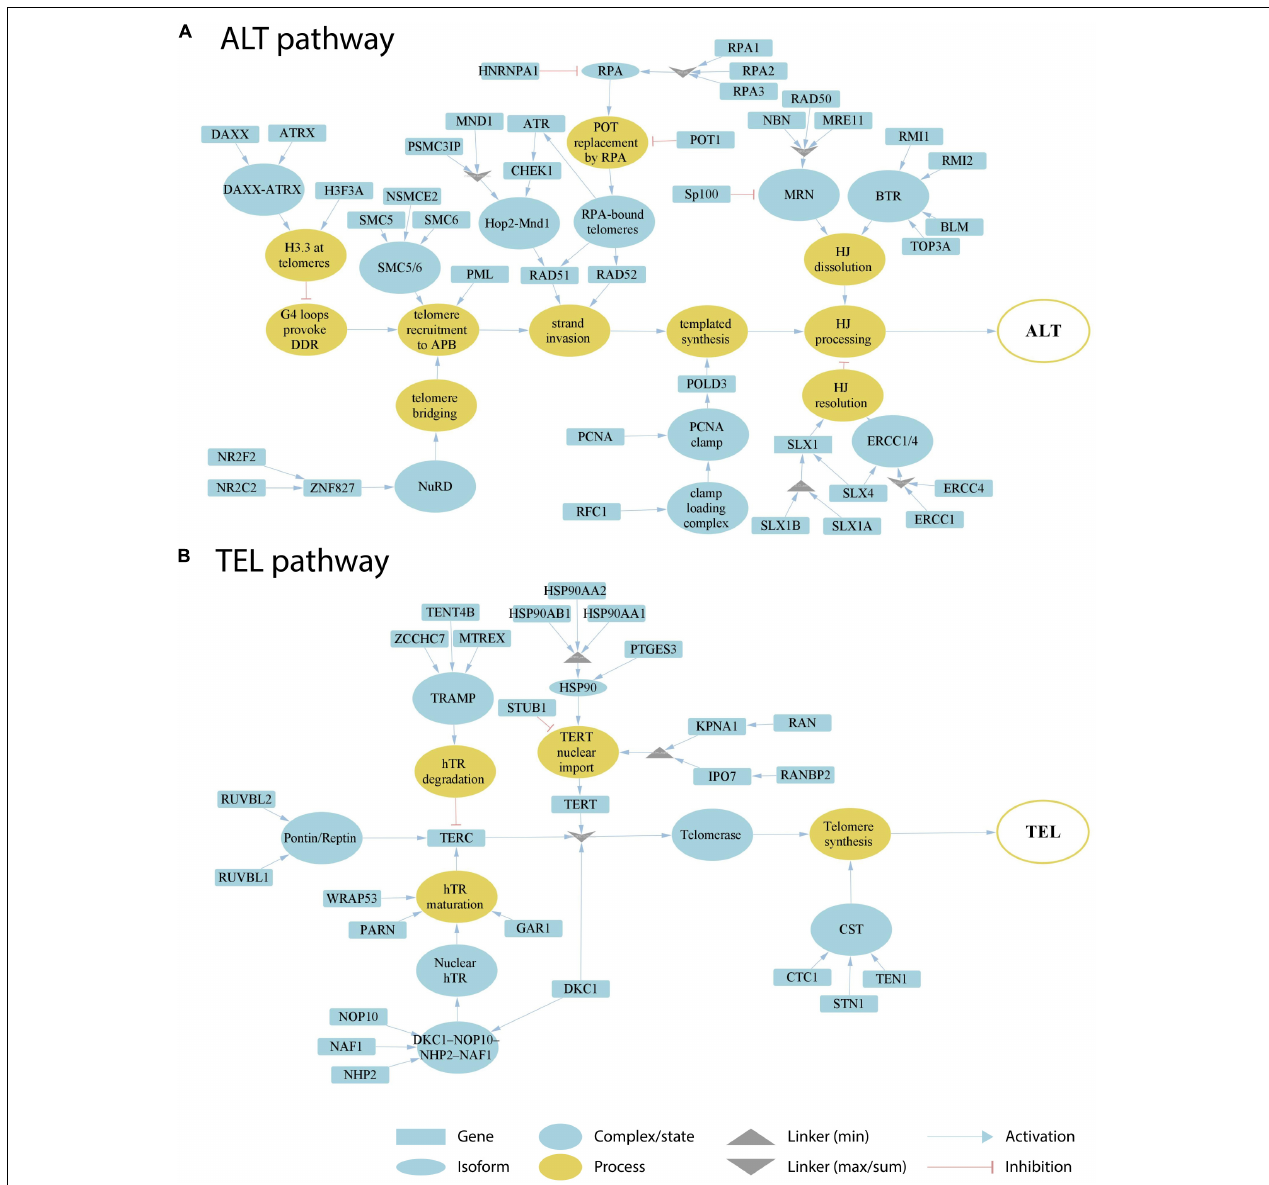
FIGURE 1 | Literature based reconstruction of the ALT (A) and the TEL (B) pathways of telomere maintenance. The ALT and TEL pathways include 37 and 26 genes based on 19 and 13 unique citations, respectively. The events leading to telomere maintenance in each pathway converge at respective final sink nodes (open circles at the right). Types of nodes and edges are defined in the figure. Linker nodes apply different operators for describing signal transduction by taking minimum or maximum values of all the input signals or their sum (see legend in the